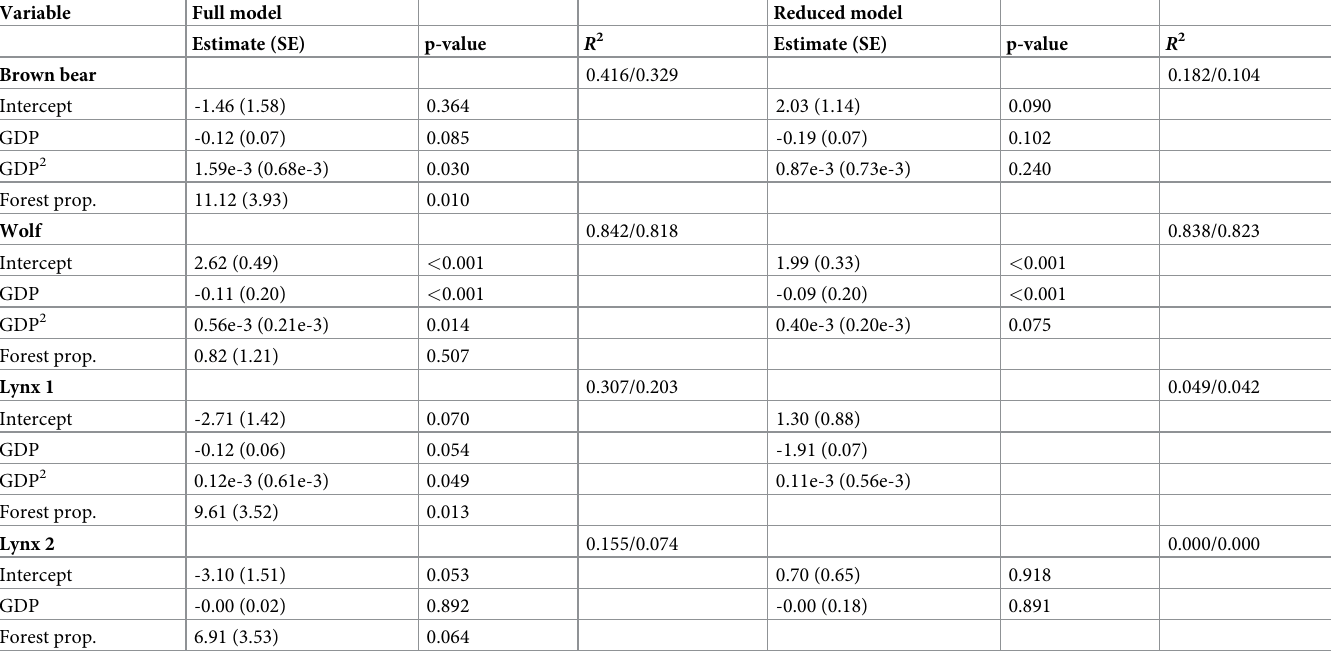
Table 1. The nonadjusted and adjusted r-squares, parameter estimates, and tests for the two linear models (full models and reduced models without proportion of forest) explaining the population density per 1000 km 2 of brown bears, gray wolves, and Eurasian lynx in European countries. Two alternative models are presented for the lynx (Lynx 1 and Lynx 2), to define the effect of the second-order term of GDP (with and without GDP 2 ).